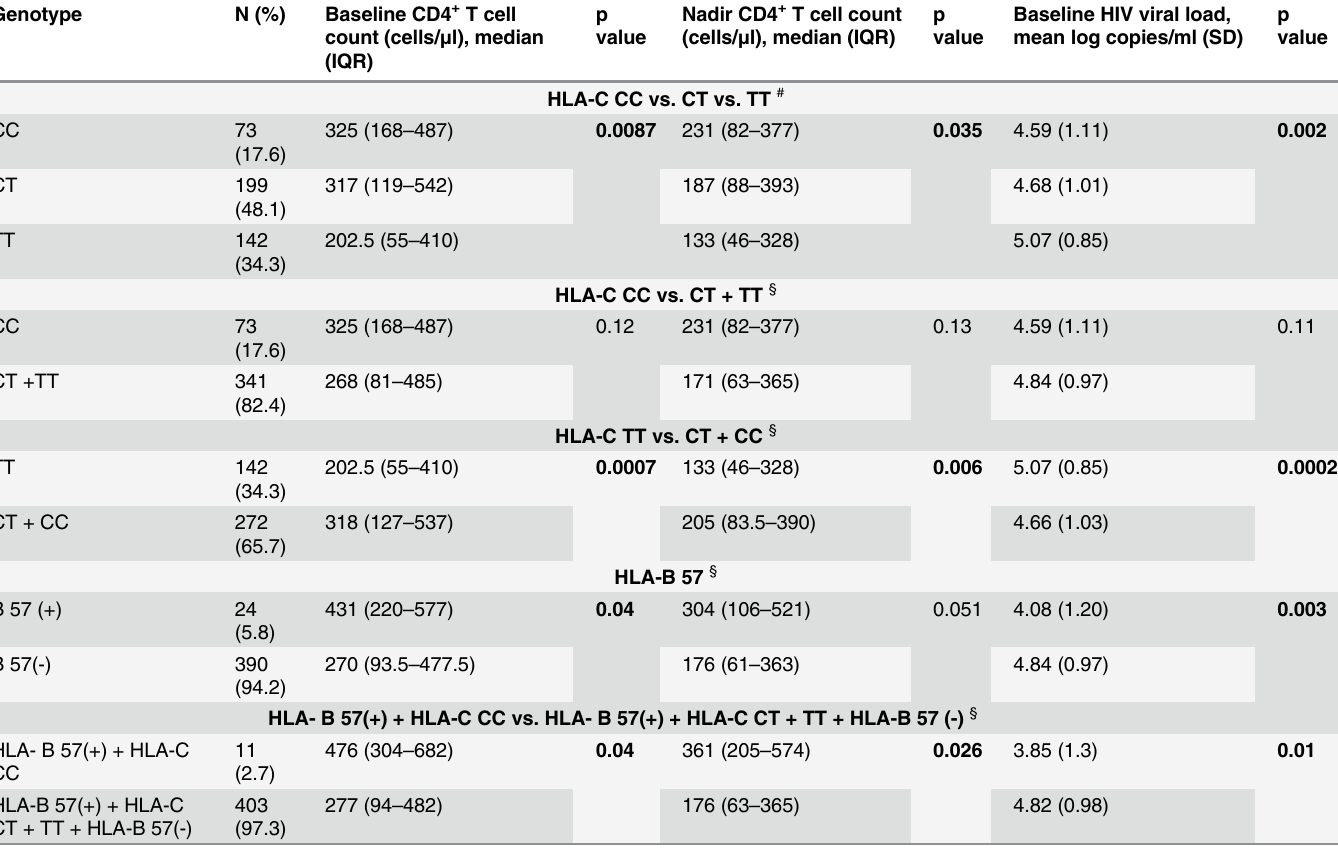
Table 2. Association between HLA – C gene variants and selected immunological and virologic data.